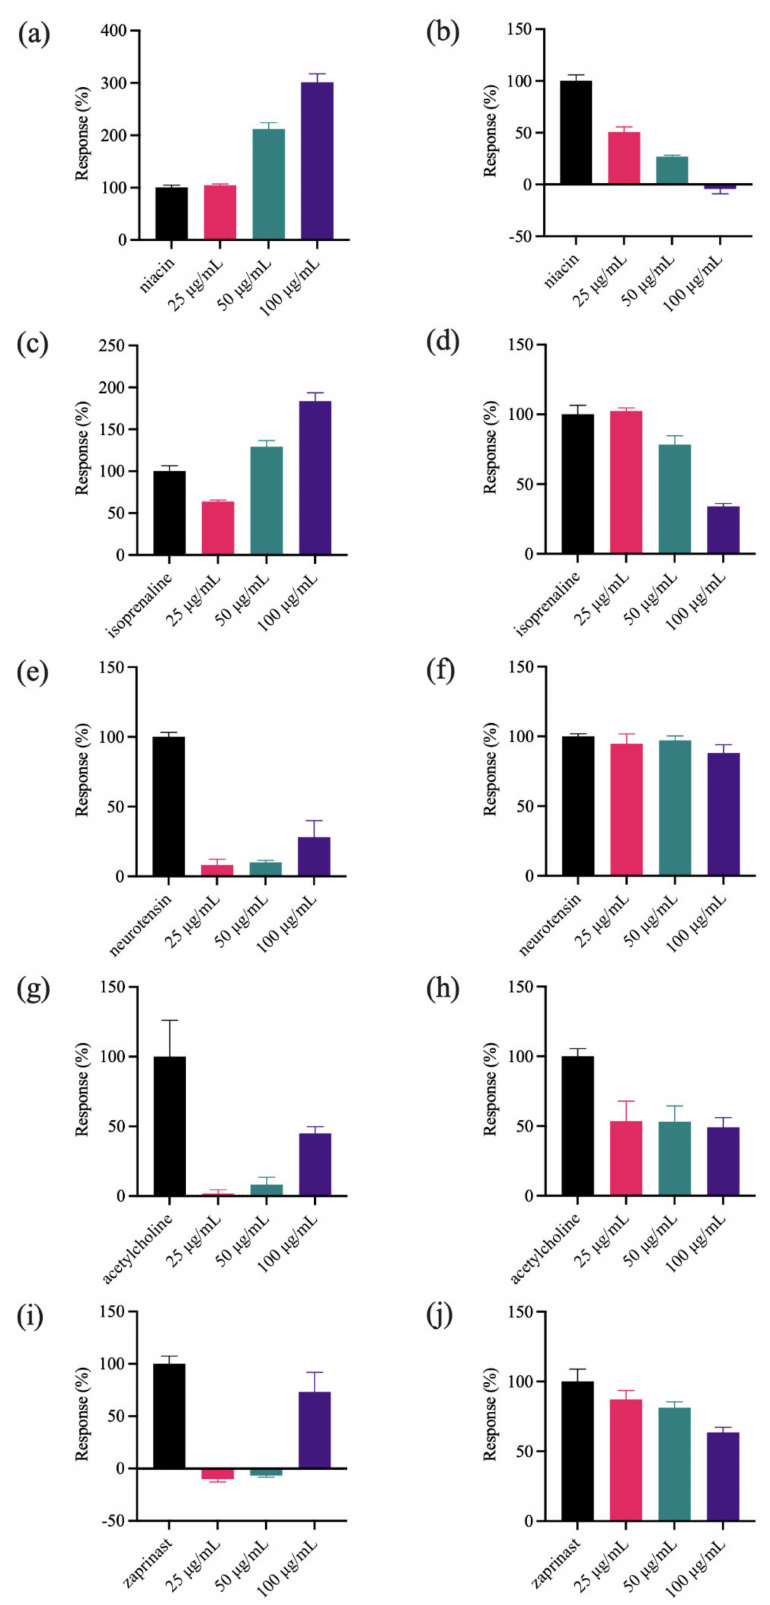
Figure 1. Target activity profiling of the polar fraction in ( a − d ) A431 and ( e − j ) HT-29 cells. ( a , c , e , g , i ) The DMR maximum amplitudes at post-stimulation of the polar fraction. The DMR maximum response of ( b ) niacin, ( d ) isoprenaline, ( f ) neurotensin, ( h ) acetylcholine and ( j ) zaprinast after the cells pre-stimulated with the polar